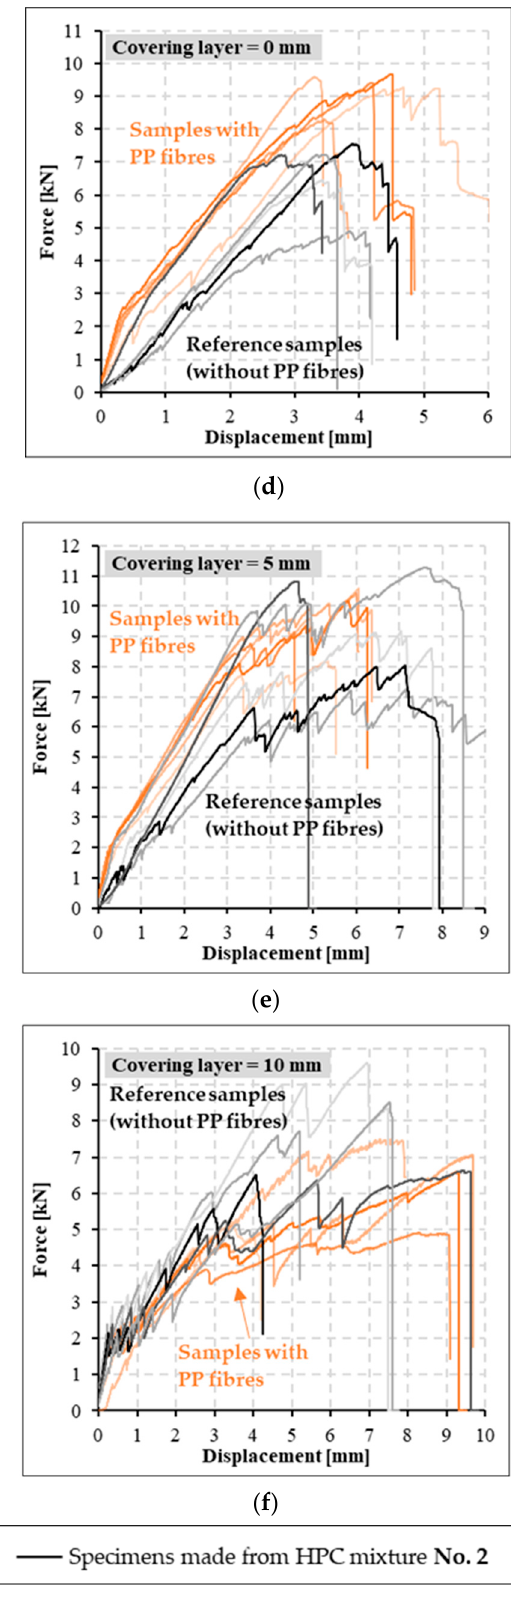
Figure 6. Bending strength of reference specimens with cement suspension matrix ( a – c ) and epoxy resin matrix ( d – f ) for different thickness of the covering layer. resin matrix ( d – f ) for different thickness of the covering